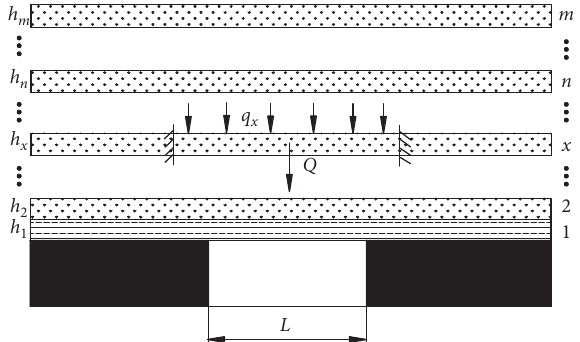
Figure 4: Mechanical model of clamped-clamped beams in the roof.